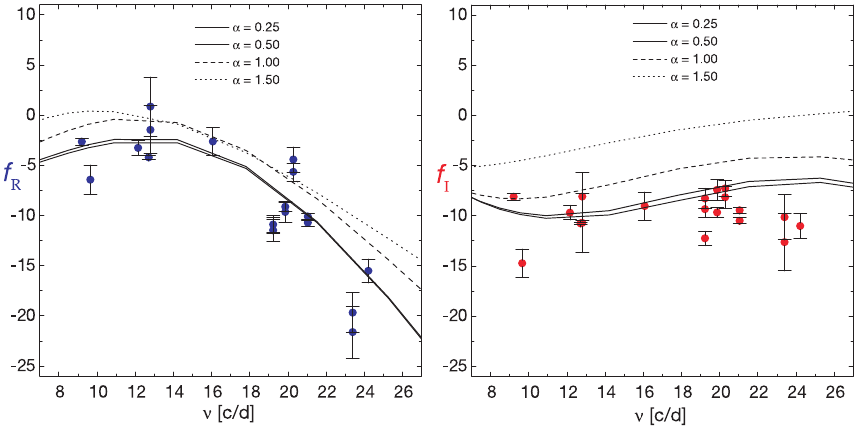
Figure 14: Comparison of the observable 𝑓 between observations in the Delta Scuti star FG Vir (filled circles with errorbars) and theory (curves). Results are plotted as a function of frequency in units of cycles/day. The model results are shown for four different values of the mixing-length parameter 𝛼 . The turbulent fluxes were obtained from the nonlocal, time-dependent mixing-length formulation of Section 3.3. The real and imaginary parts of 𝑓 are shown in the left and the right panels, respectively. Image reproduced with permission from Daszy´nska-Daszkiewicz et al. (2005), copyright by